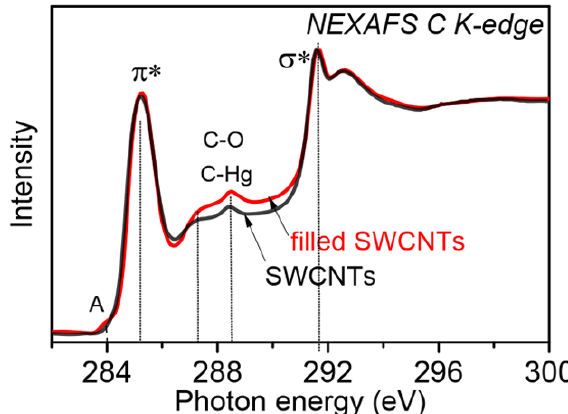
Figure 6. The C 1s NEXAFS spectra of SWCNTs and HgCl 2 -filled SWCNTs. The label A marks a new feature. Reprinted with permission from Fedoseeva Y.V. et al. Single-walled carbon nanotube reactor for redox transformation of mercury dichloride, ACS Nano. 2017. V.11. N.9. P.8643-8649. Copyright 2017 American Chemical Society [140].